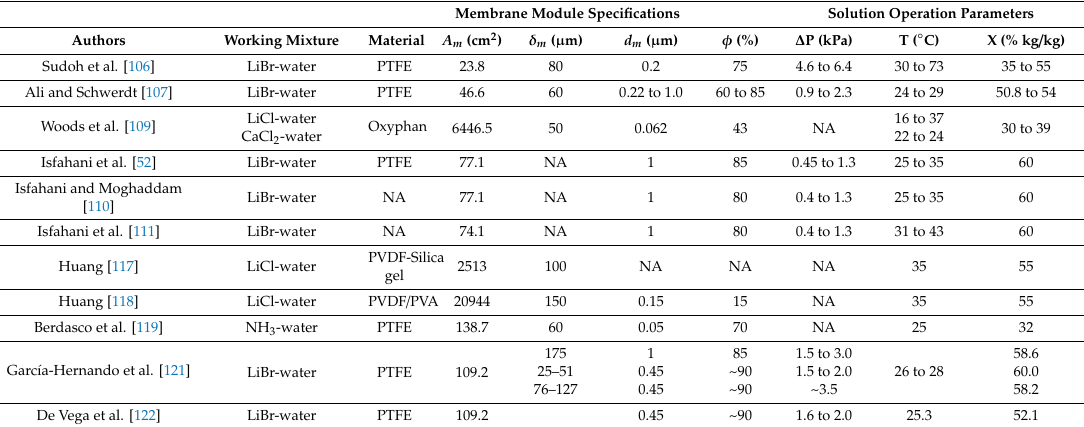
Table 2. Experimental studies carried out on membrane